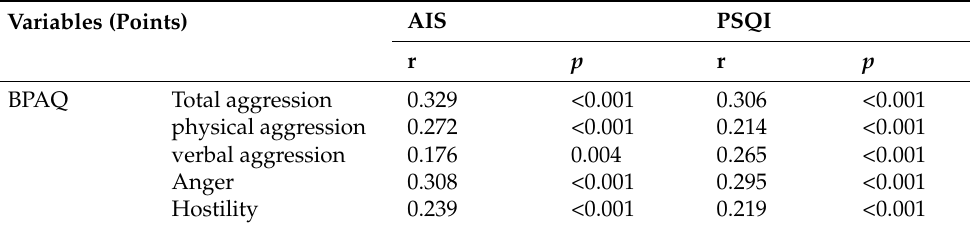
Table 9. The correlation of sleep disorder on intensity of